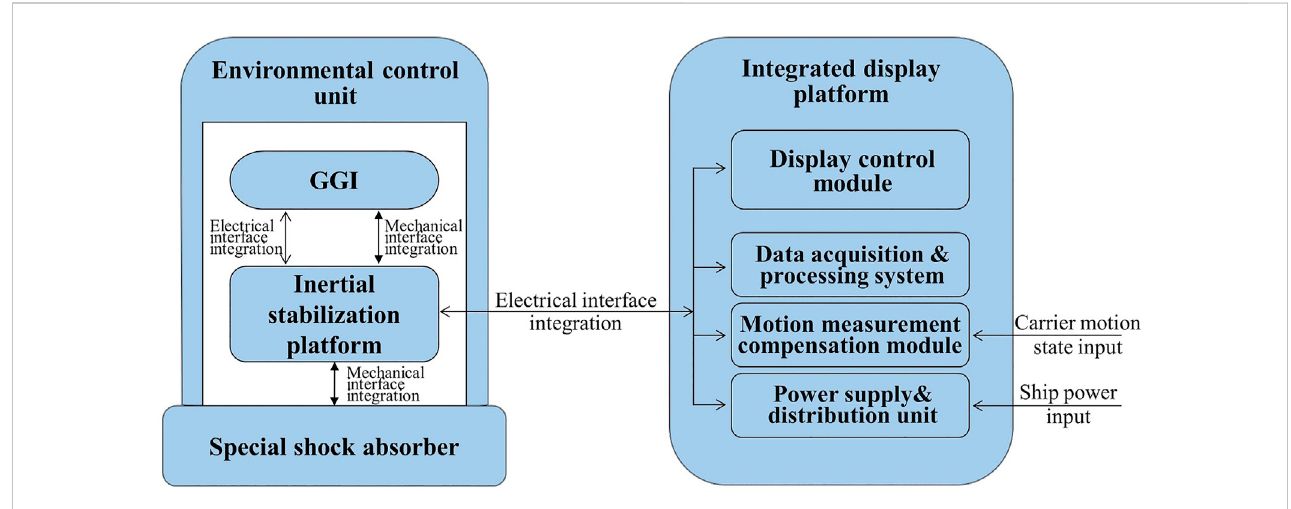
FIGURE 4 Integration scheme of shipboard